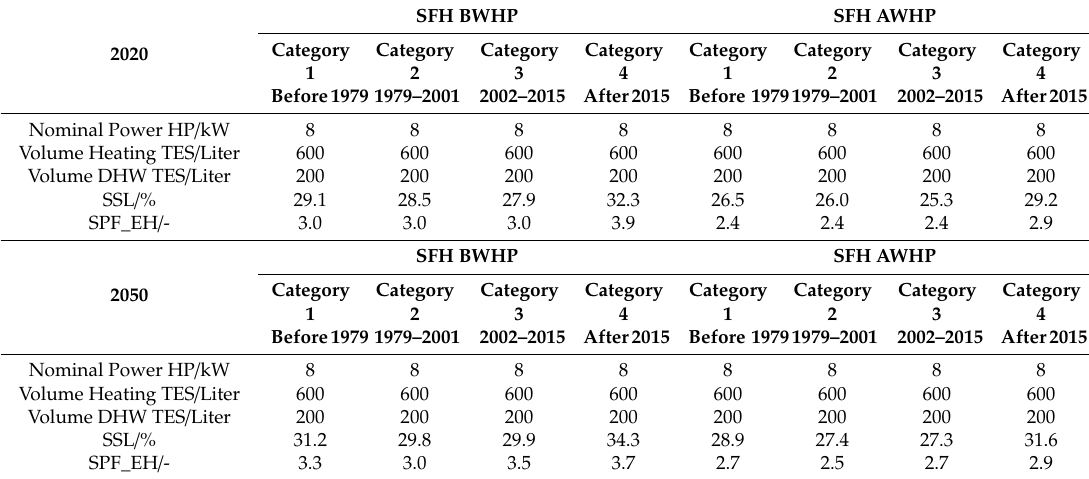
Table 1. Summary of simulation results for SFH reference buildings for BWHP and air–water heat pump (AWHP) as well as for 2020 and 2050.